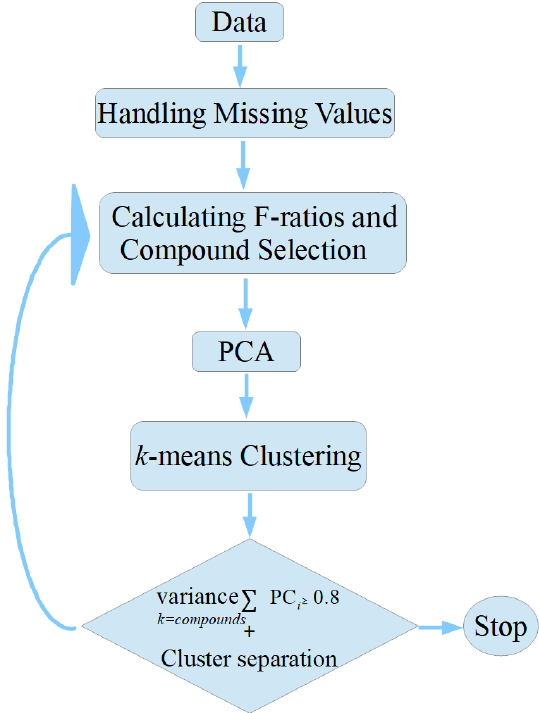
Figure 1. Pattern recognition algorithm